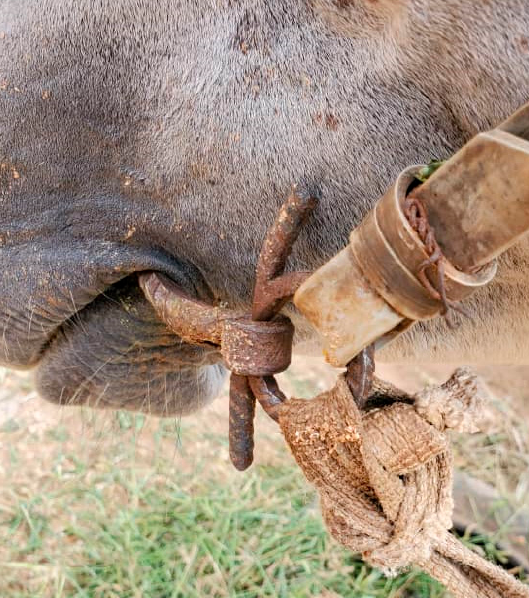
Figure 5. Locally produced bit in Senegal with ridged surfaces and protruding cheek ‐ pieces that contact the skin of the horse’s face.